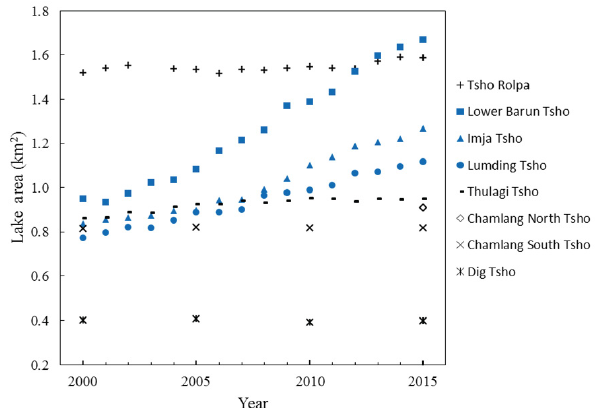
Figure 6. Area of glacial lakes derived from satellite imagery using the NDWI method from 2000 to 2015 (details in Table S.7).